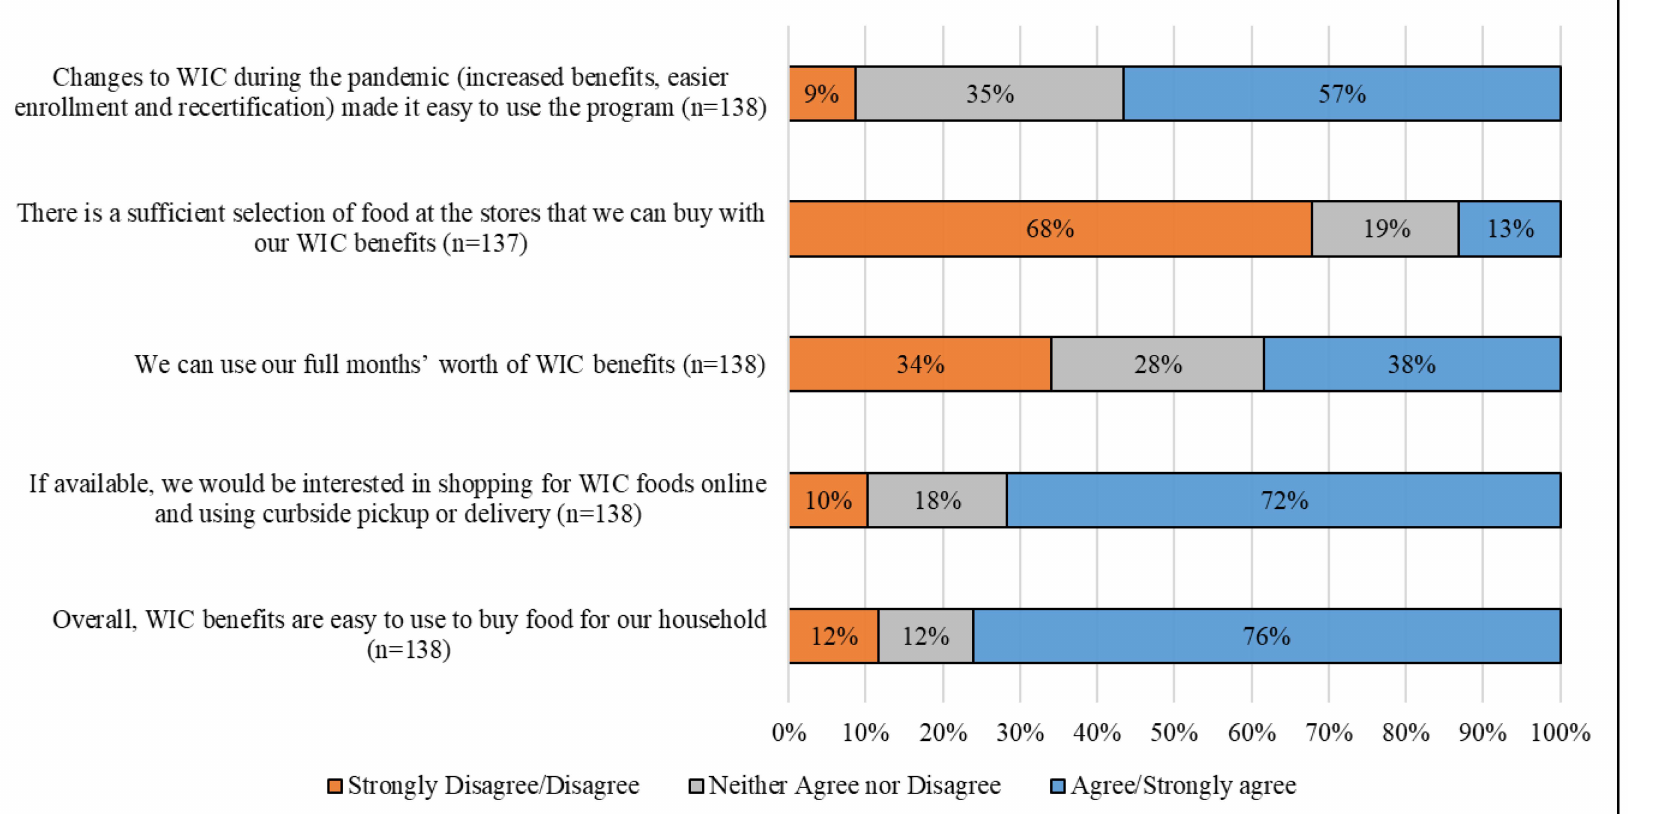
Figure 2. Perceptions of the Special Supplemental Nutrition Program for Women, Infants, and Children (WIC) use during the Coronavirus Disease 2019 (COVID-19) pandemic † . † Respondent numbers across questions vary due to